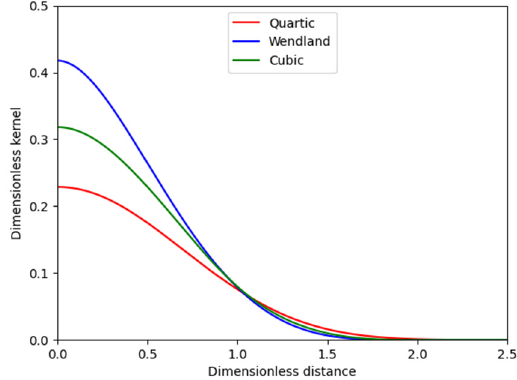
Figure 3. Comparison of the kernels used in this work.